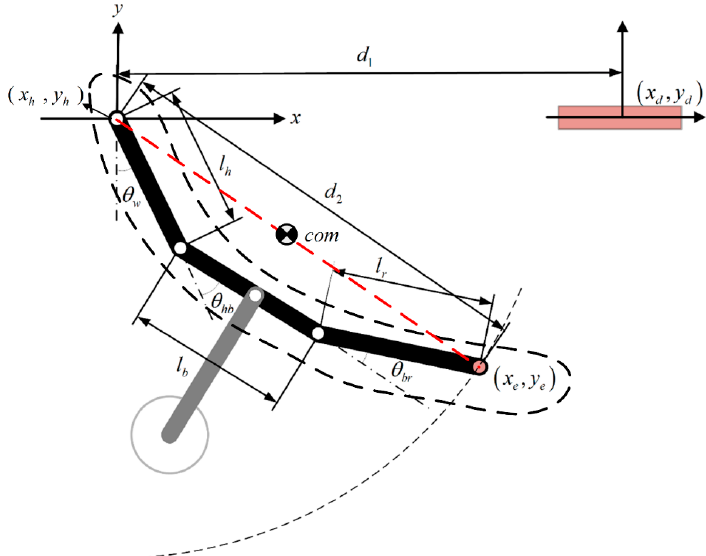
Figure 3. Robot swing trajectory while maintaining a simplified two-link robot posture. The dashed line indicates the trajectory of the lumped link combining the body link and two arm links.